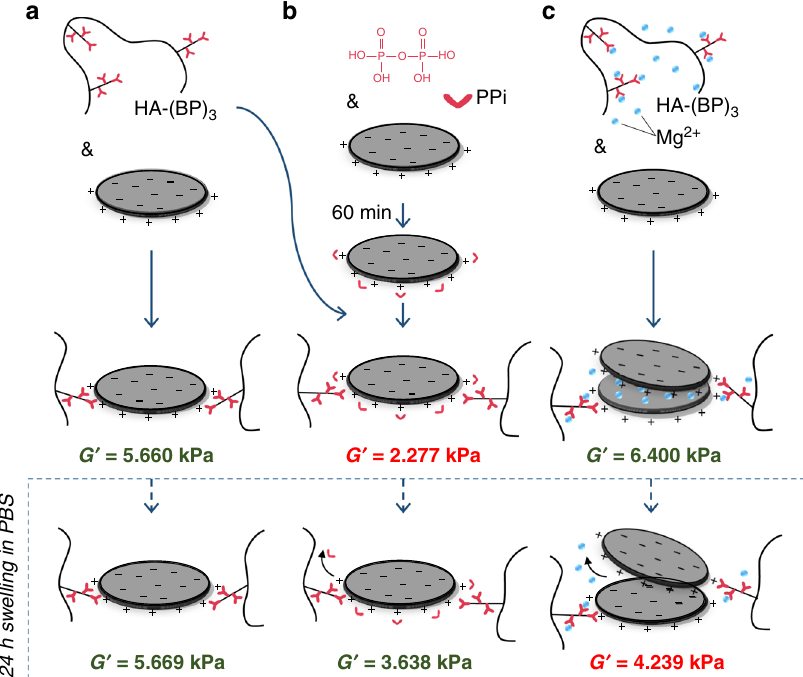
Fig. 4 HA-BP • Laponite gels are compromised by edge-site or bisphosphonate-associating ions. Compared with gels prepared in the absence of pyrophosphate ( a ), screening of Laponite edge sites with pyrophosphate ions (PPi) prior to mixing with HA-(BP) 3 reduced the stiffness of the gels by half. Stiffness partially recovered post swelling suggesting release of PPi and the formation of new physical cross-links ( b ). Preincubation of HA-(BP) 3 with BP- competing Mg 2 + ions caused an initial increase in gel stiffness consistent with Mg 2 + cation bridging of Laponite particles. Osmotic release of interlayer Mg 2 + revealed that swelling-resistant BP • Laponite cross-links ( a ) were compromised by addition of Mg 2 + ( c ). Storage modulus ( G ′ ) is recorded at 1